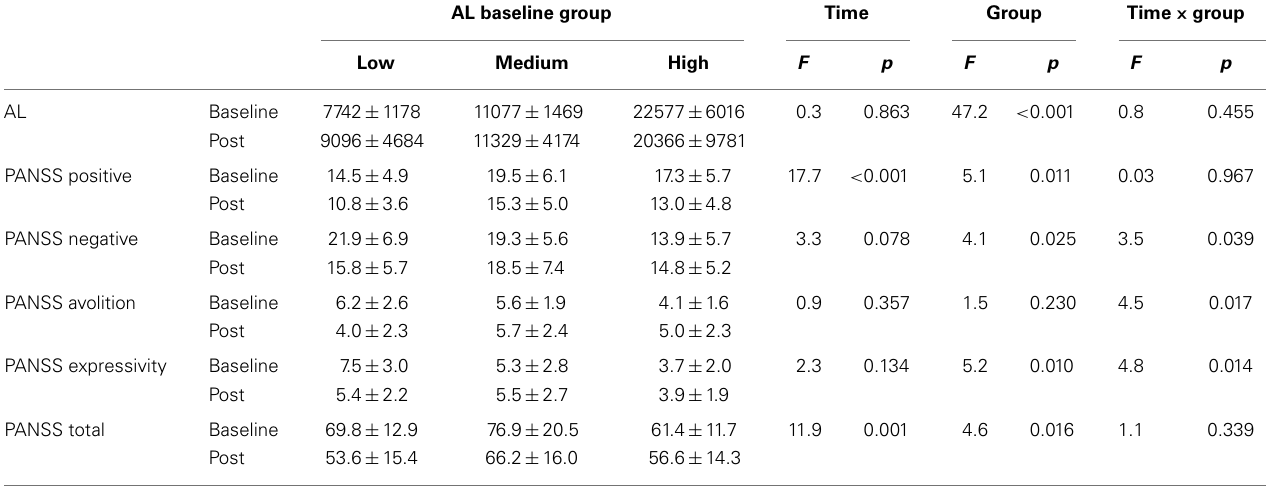
Table 2 | Repeated measuresANOVAs within episode